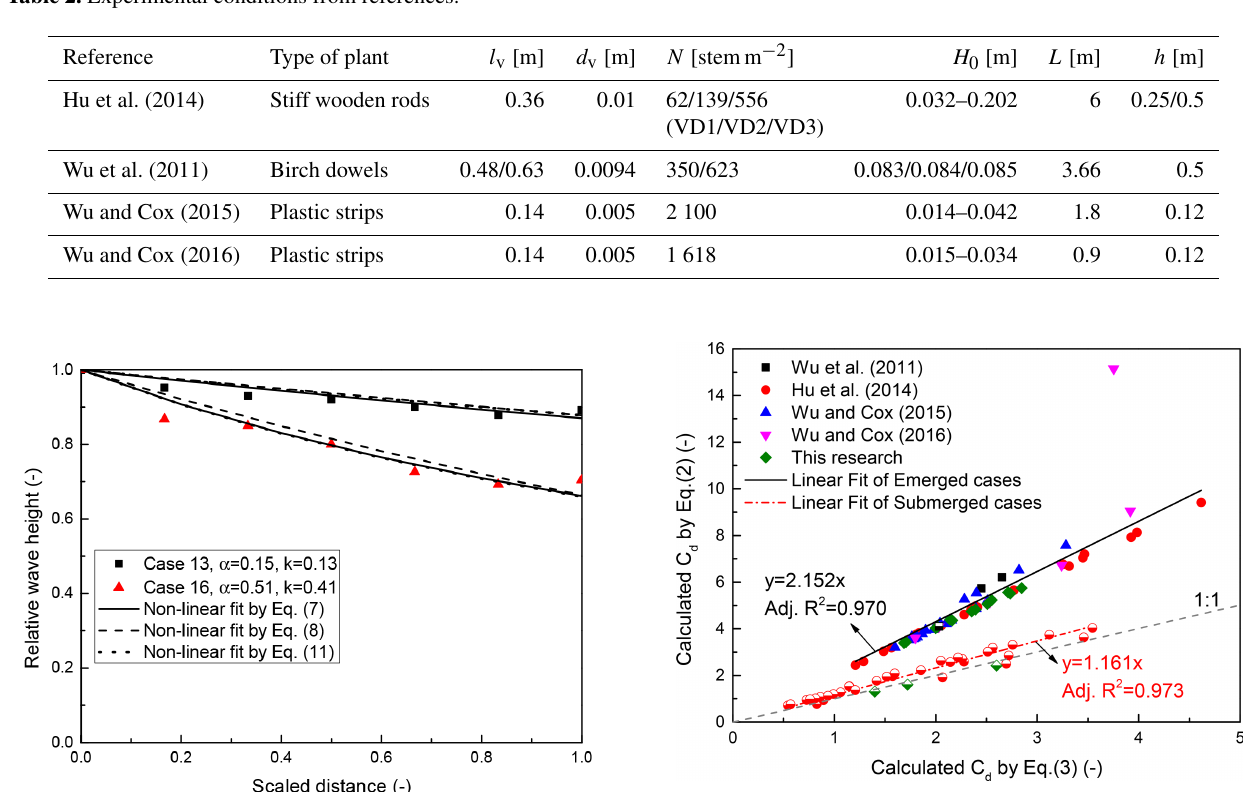
Table 2. Experimental conditions from references.